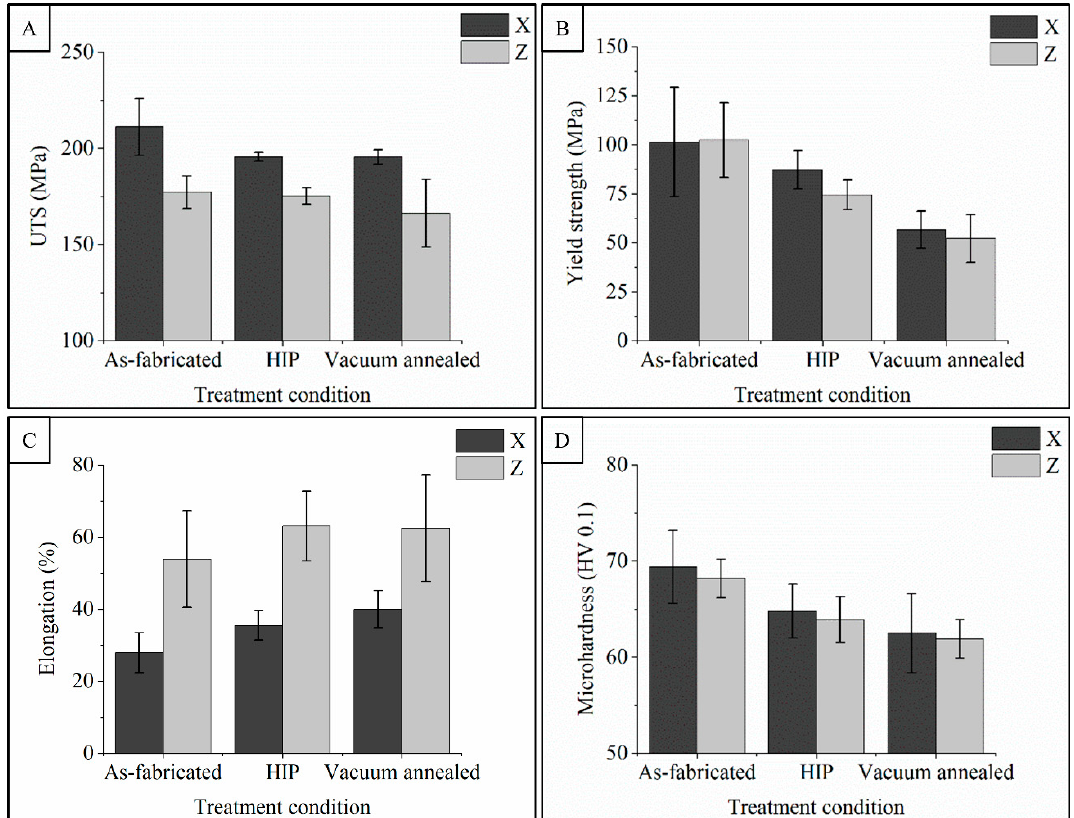
Figure 6. Mechanical properties summary and selected statistical observations; ultimate tensile strength ( A ), yield strength ( B ), elongation to failure ( C ), Vickers microhardness ( D ). Error bars indicate a 95% confidence interval based on the pooled variance of all samples.